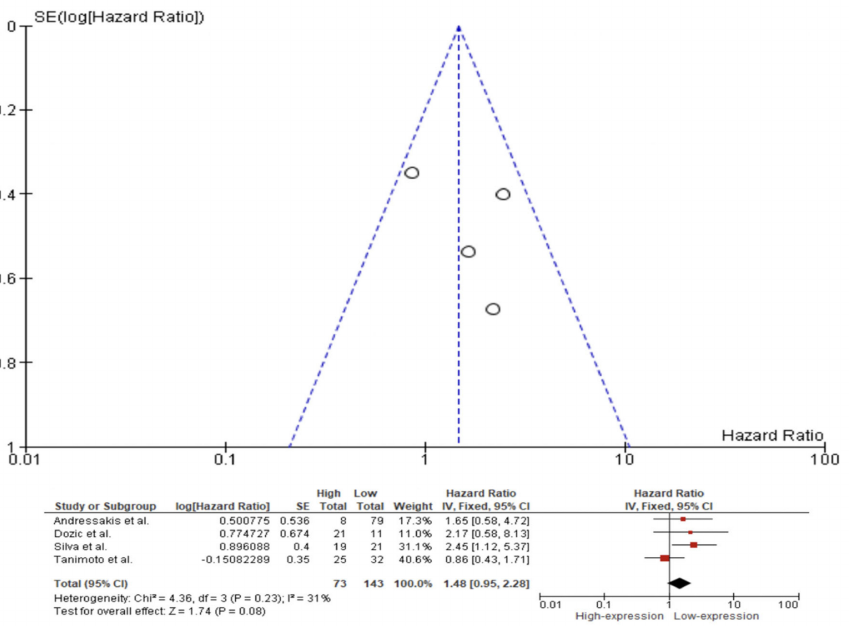
Figure 4. Forest plot and funnel plot for the association of higher Caspase 3 expression with overall survival. Squares represent study-specific hazard ratios; horizontal lines represent 95% confidence intervals (CIs); diamonds represent the overall hazard ratio estimate with its 95% CI [5,14,27,70].